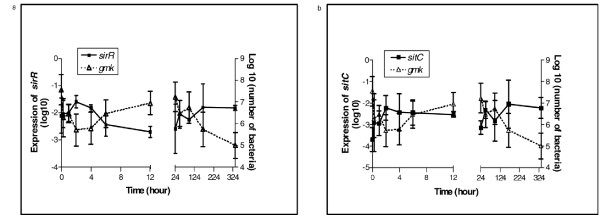
In vivo gene expression in sessile bacteria from implantation up to 2 weeks after implantation. Expression levels at time 0 represent the expression levels on the catheter just before implantation. In the left y-axis, gene expression (full line with filled square) is quantified as the log10 (cDNA/gDNA). The right y-axis gives the evolution of the number of sessile bacteria during in vivo foreign body infection. The number of bacteria is quantified by the log10 of the number of copies of gmk (dotted line with unfilled triangles). The error bars represent the standard deviations. The line that links the data points helps to clarify the results at each time point measured. The time is given in hours in the x-axis. Sixteen independent samples were assessed at each time point.